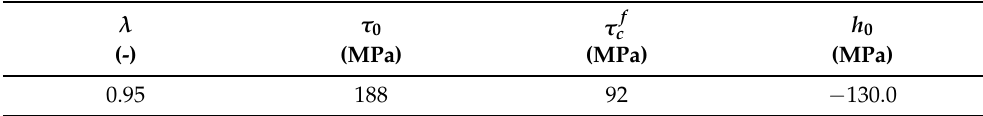
Table 6. Re-calibrated CPFE model parameters for uniaxial fatigue loading (set 2). The remaining material parameters are unchanged with respect to set 1 and given Table